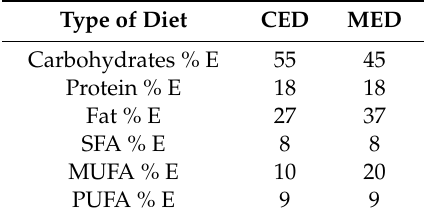
Table 1. The composition of the both compared